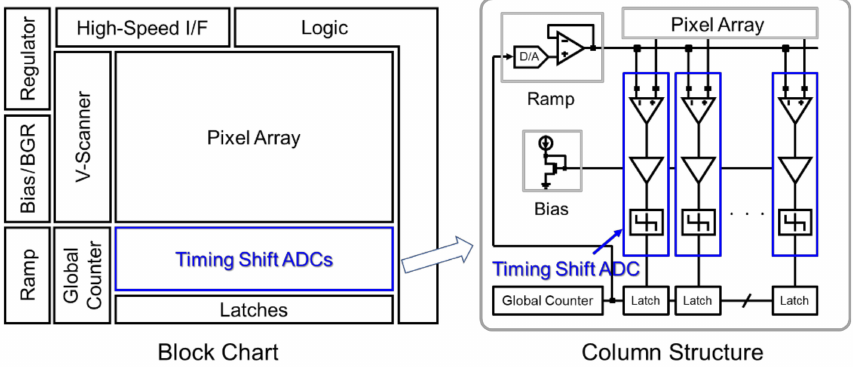
Figure 1. Block chart of an image sensor and one column